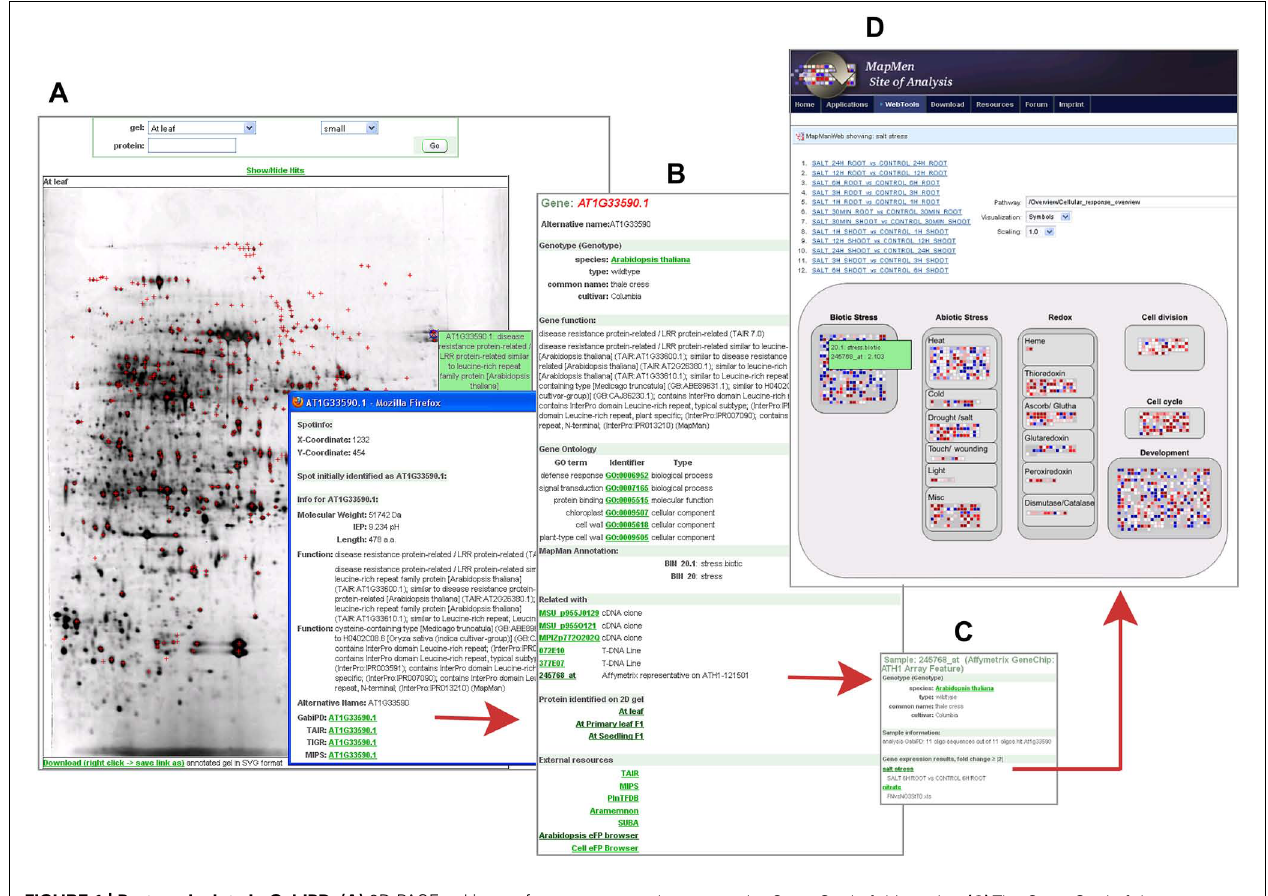
the user to the GreenCard of this probe. (C) The GreenCard of the Affymetrix probe-set 245768_at includes, beside the probe description, a list of related transcriptomic experiments where the transcript is significantly up- or down-regulated, e.g., a salt stress experiment. The related experimental data are linked. (D) MapManWeb user interface at the MapMan Site of Analysis displaying the results of the salt stress transcriptomic experiment in A. thaliana . AT1G33590.1 is up-regulated as indicated by a blue filled rectangle